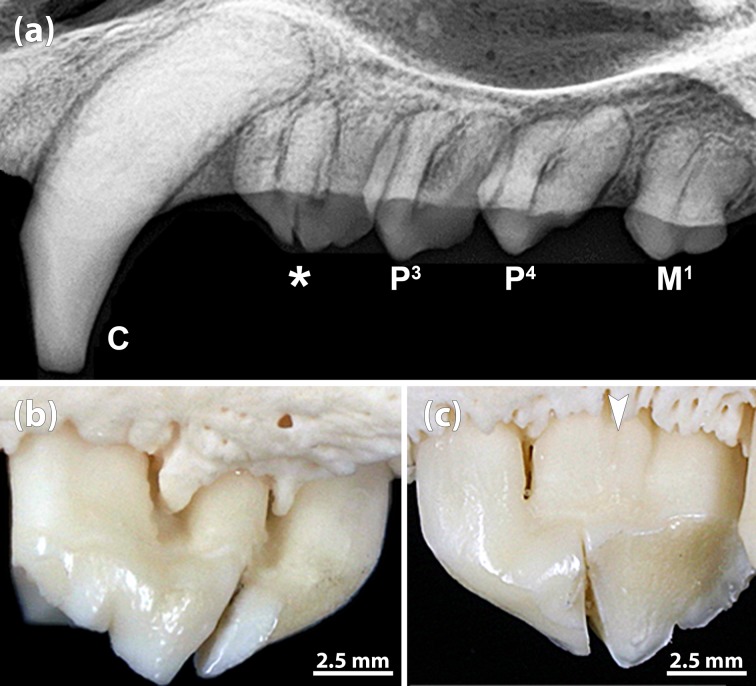
Abnormal crown and root morphology in an 18-year-old male Eastern Atlantic harbor seal (Phoca vitulina vitulina, specimen ZIK 29091), diagnosed as a case of incomplete fusion of P1 and P2.(a) Radiograph (mediolateral projection) of maxillary right canine and postcanine teeth. Asterisk: incompletely fused right P1 and P2. Note hypercementosis on the roots of the postcanine teeth. (b) Buccal view (mesial to the right) of incompletely fused right P1 and P2 (crowns separate). (c) Palatal view (mesial to the left) of incompletely fused right P1 and P2. Arrowhead: shallow furrow on the central root.